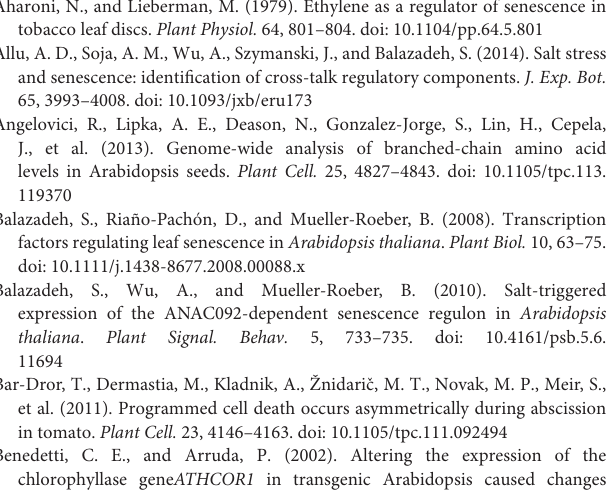
Supplementary Figure 1 | The sampled leaf tissues and the relationship between leaf senescence and different NaCl concentration treatments. (A) The leaves detached for treatment-induced senescence. (B) The relationship between leaf senescence and different concentrations of NaCl. Supplementary Figure 2 | The validation of RNA-seq data via qRT-PCR. The relative expression fold change of the representative senescence-associated genes (SAGs) from different clusters in Figure 5 in different conditions compared with day 0. Supplementary Figure 3 | Significant Gene Ontology (GO) distribution for molecular function of 1546 senescence-associated genes (SAGs) in Figure 4D . Supplementary Figure 4 | Gene Ontology (GO) enrichment analysis of senescence-associated genes (SAGs) shared by darkness and salt-induced leaf senescence on day 2 ( A for Figure 4A , 3011 genes enrichment analysis), 4 ( B for Figure 4B , 3787 genes enrichment analysis), and 6 ( C for Figure 4C , enrichment analysis of 4419 genes) treatment in detached Medicago truncatula leaves. Only the GO term